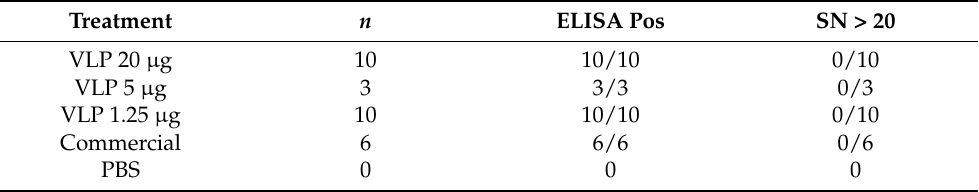
Table 4. Serum samples from survivors and the results from ELISA and Serum neutralization